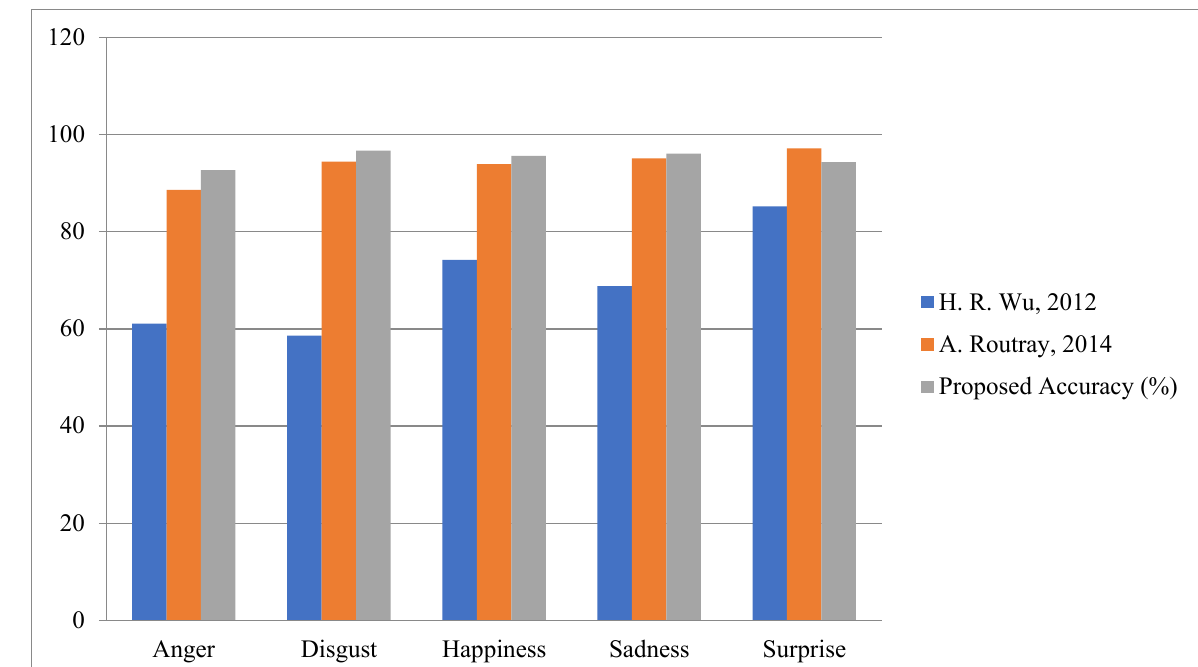
20 of 24 Figure 16. Accuracy Comparison for Gender Classification on IOG. Fourth Module: Finally, in the fourth module, the proposed work is evaluated for various face expression on benchmark datasets, i.e., CK+ and JAFFE. According to Ta-